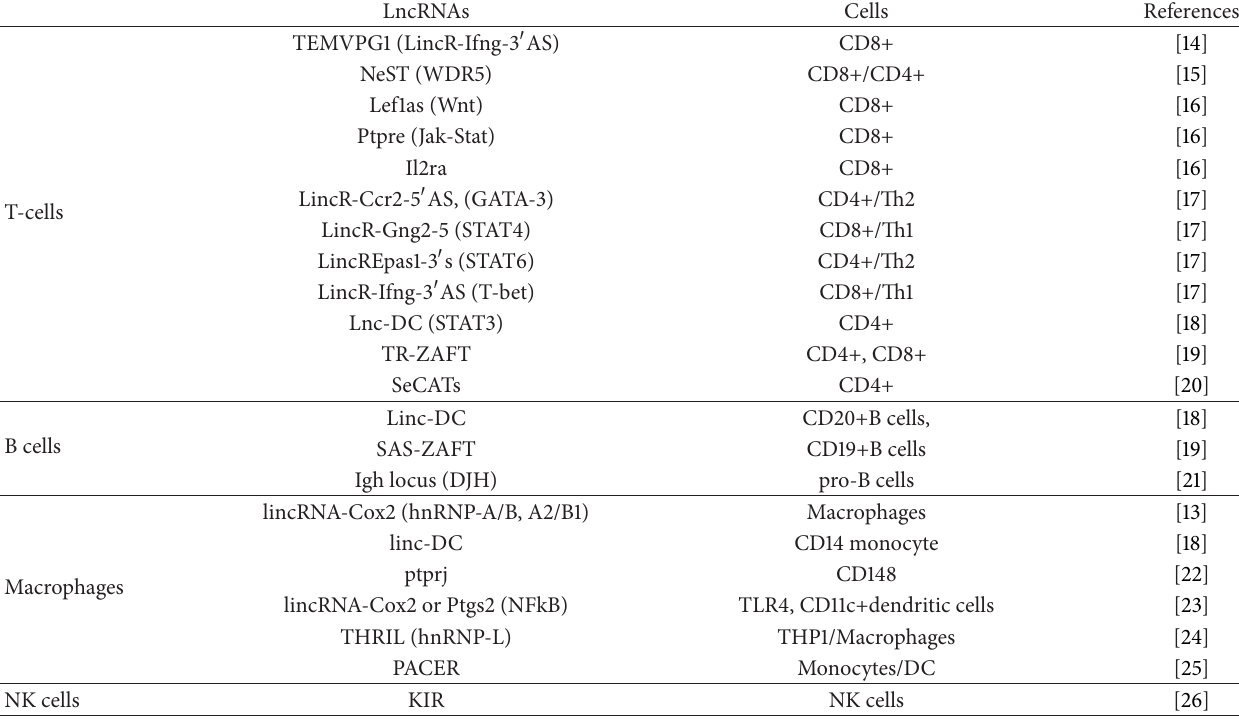
Table 1: LncRNAs associated transcription factors, genes, and cells in autoimmunity.